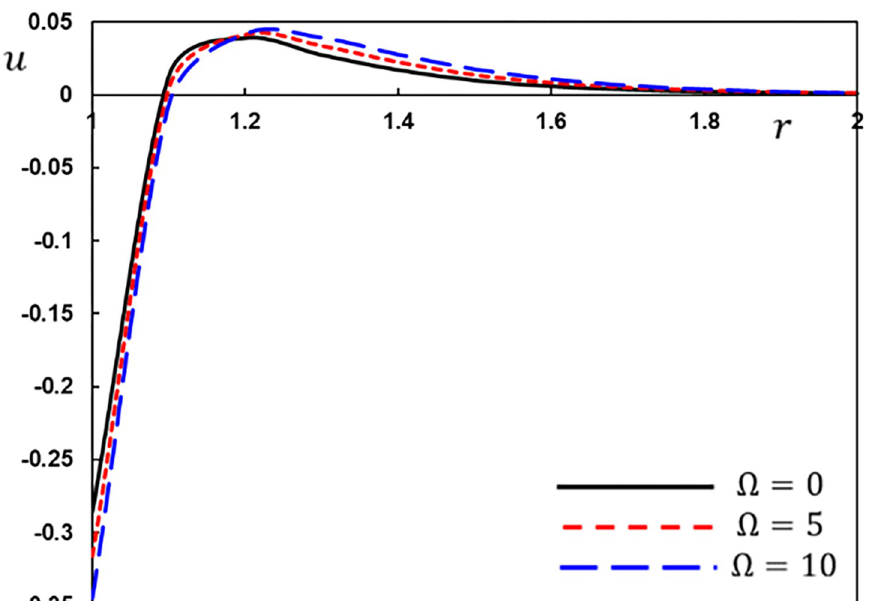
Fig 6. The displacement variation u for different values of the rotation speed O